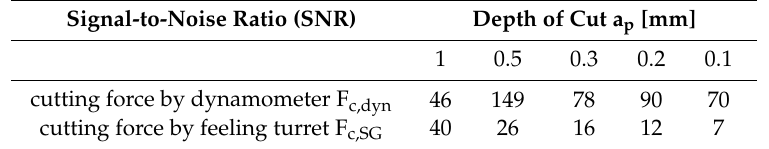
Table3. Signal-to-noiseratioforthemeasuredcuttingforcebyusingthedynamometerandfeelingturret.